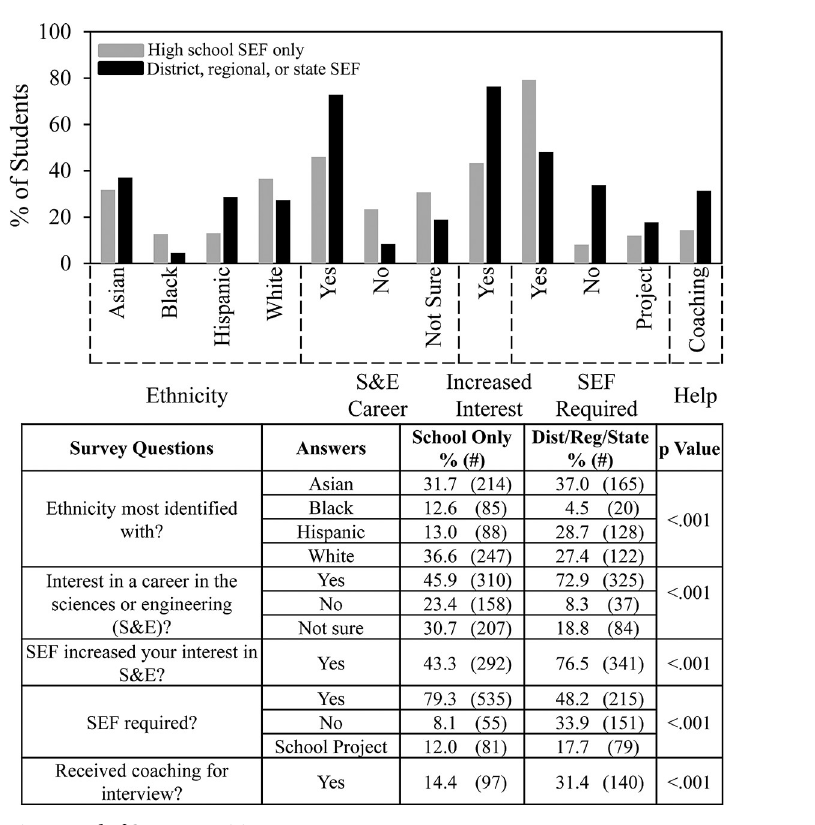
Fig 6. Level of SEF